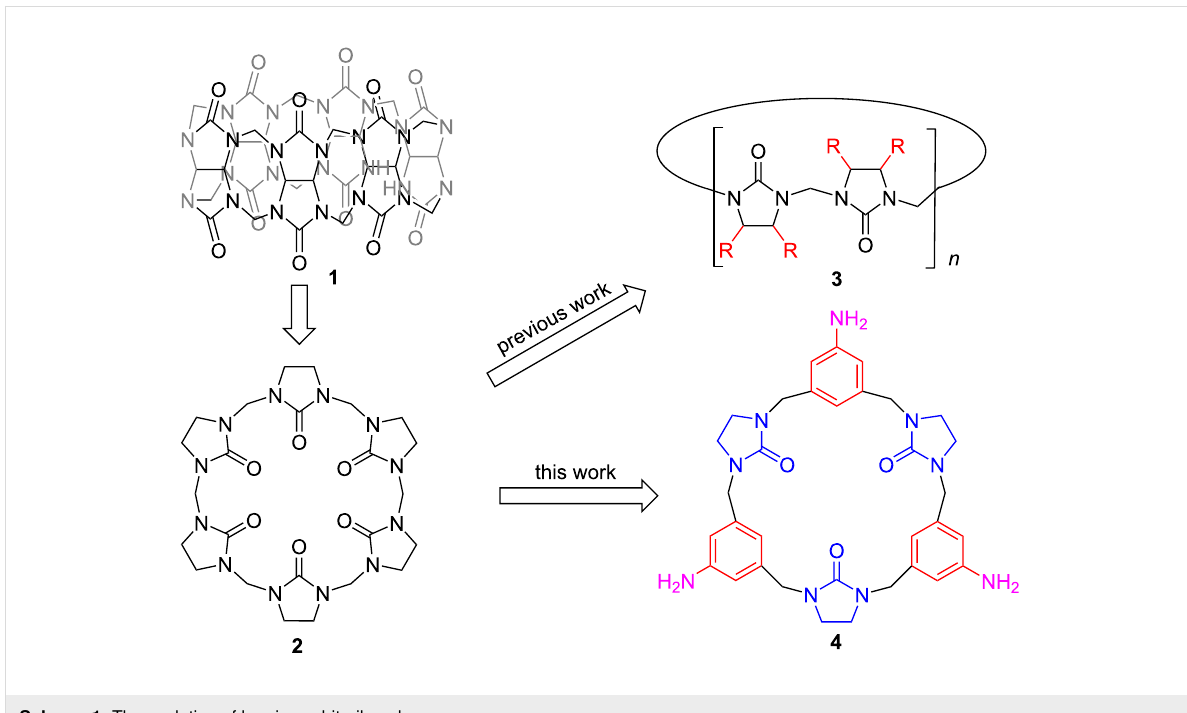
Scheme 1: The evolution of hemicucurbituril